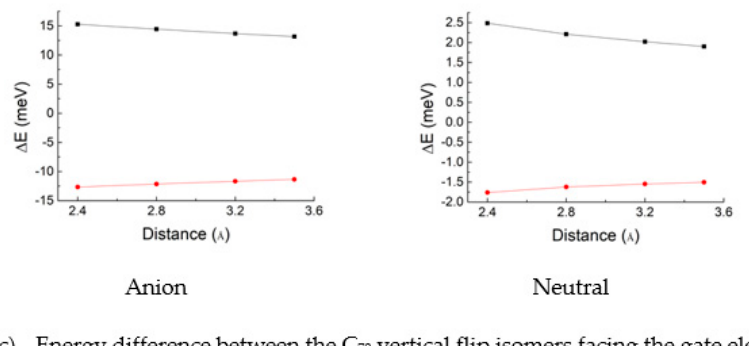
Figure 4. C 70 - point charge interaction energy, ∆ E , calculated as a function of the distance between the model surface of point charges δ and the closest atoms of C 70 chemical species to the surface: in ( a , b ), a blue line represents the interaction energy between fullerene and a point charge model of the gate electrode, in which the major axis faces the gate electrode surface, and a red line represents when the minor axis faces the gate electrode surface. ( c ) ∆ E values for δ = − 0.01 are represented by filled blue circles, and those for δ = +0.01 by filled red circles. Here, the q values (= − 0.01 and 0.01) were chosen to be the energy barrier of approximately 11 meV for the C 70 vertical flip by simulating q from − 0.04 to 0.04 with step 0.01.